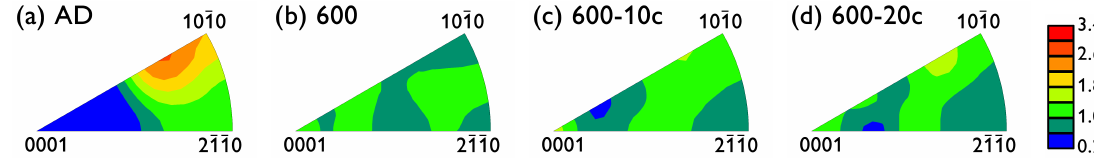
Figure 2. EBSD inverse pole figures of the selected samples: ( a ) AD sample, ( b ) sample 600, ( c ) sample 600-10c, and ( d ) sample 600-20c. The intensity scale bar (multiples of a random distribution) is valid for all the